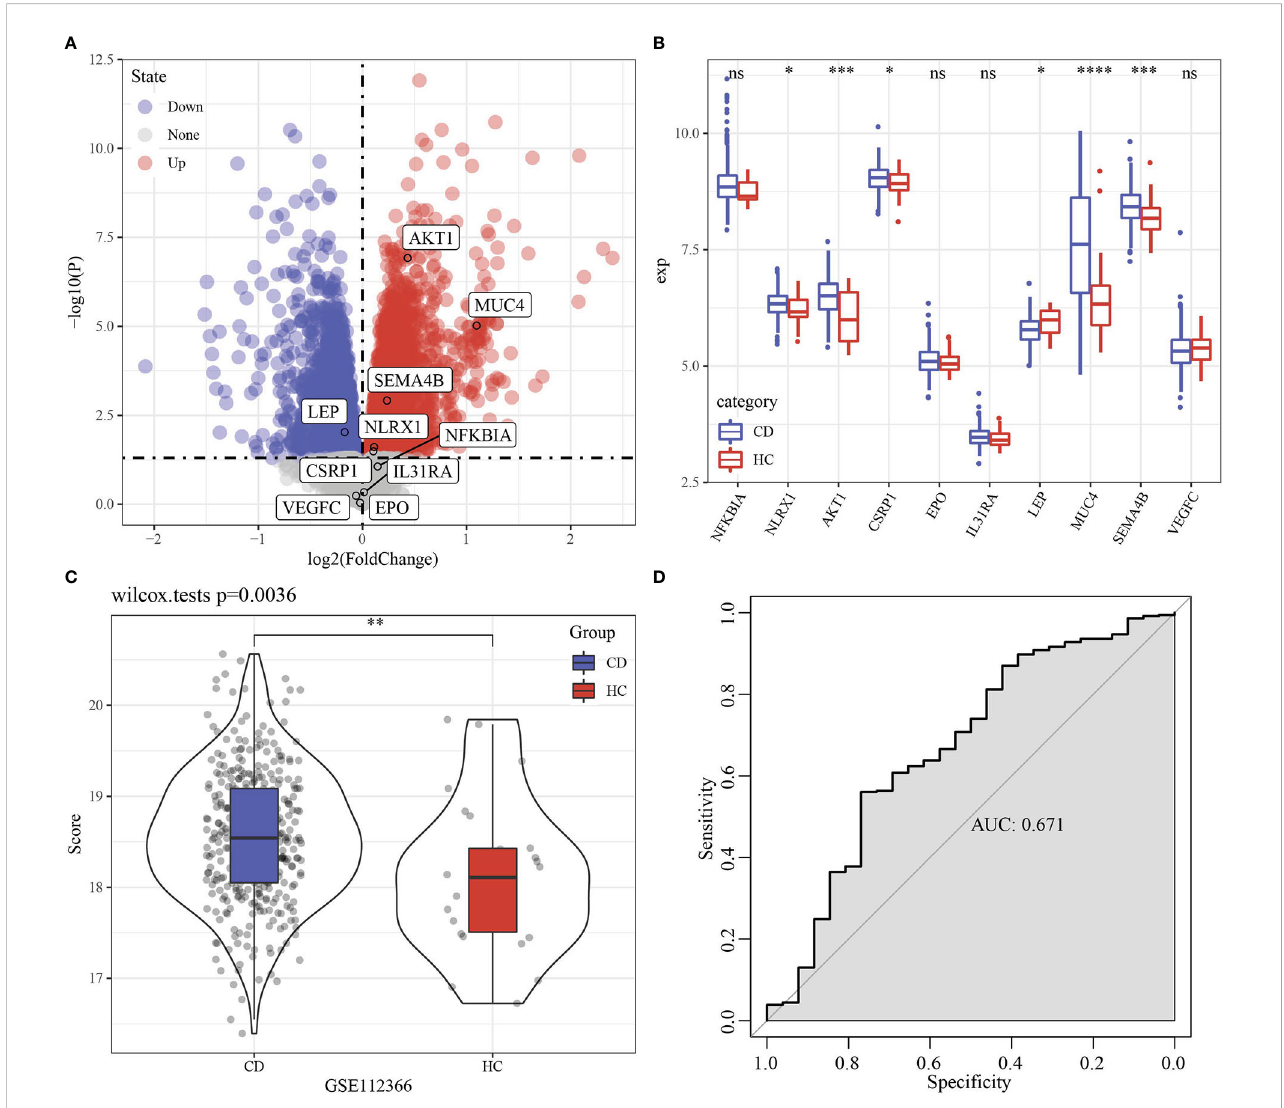
FIGURE 12 Performance examination of RiskScore in Crohn ’ s disease. (A) Volcano Plot of differentially expressed genes in GSE112366 dataset. (B) Boxplot of differentially expressed genes between Crohn ’ s disease and healthy samples in GSE112366 dataset. (C) RiskScore difference of between Crohn ’ s disease and healthy samples in GSE112366 dataset. (D) ROC curve of RiskScore in dataset GSE112366 dataset. * p<0.05, ** p<0.01, *** p<0.001, **** p<0.0001, ns, no